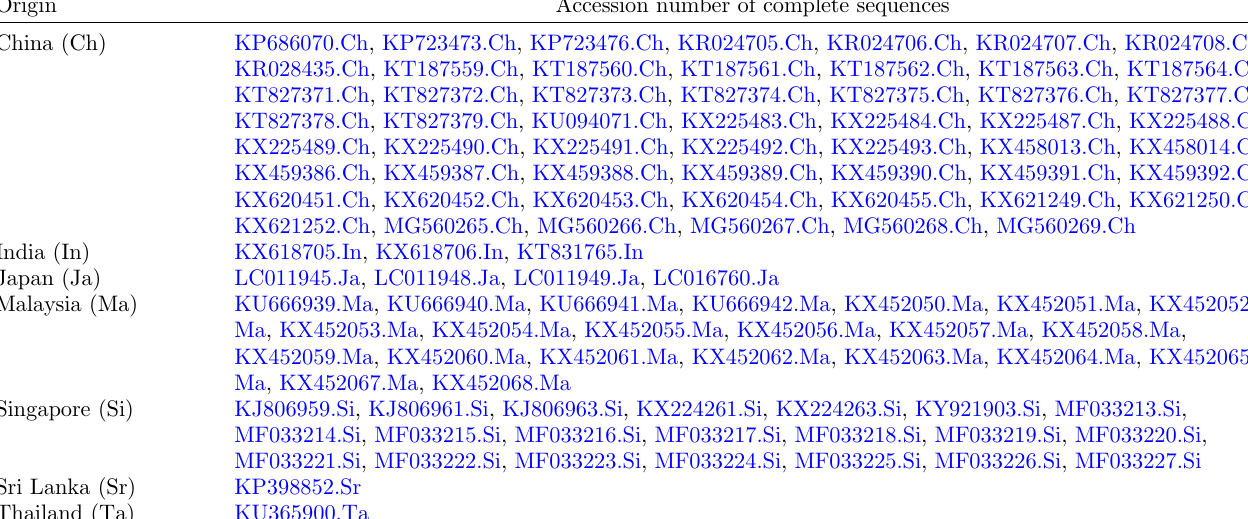
Table 5. List of accession numbers (NCBI base) of complete sequences of Dengue virus Type 1, year 2014 – from Asia. The fi rst column shows the country and the second column shows the sequences coming from the country, on the left.